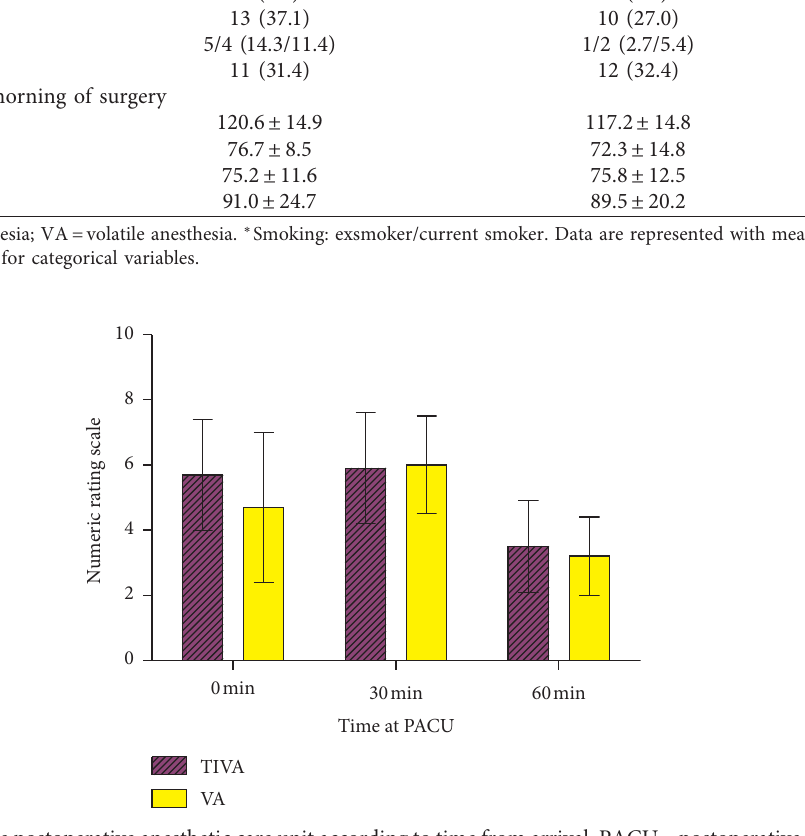
Figure 2: Pain intensity at the postoperative anesthetic care unit according to time from arrival. PACU � postoperative anesthetic care